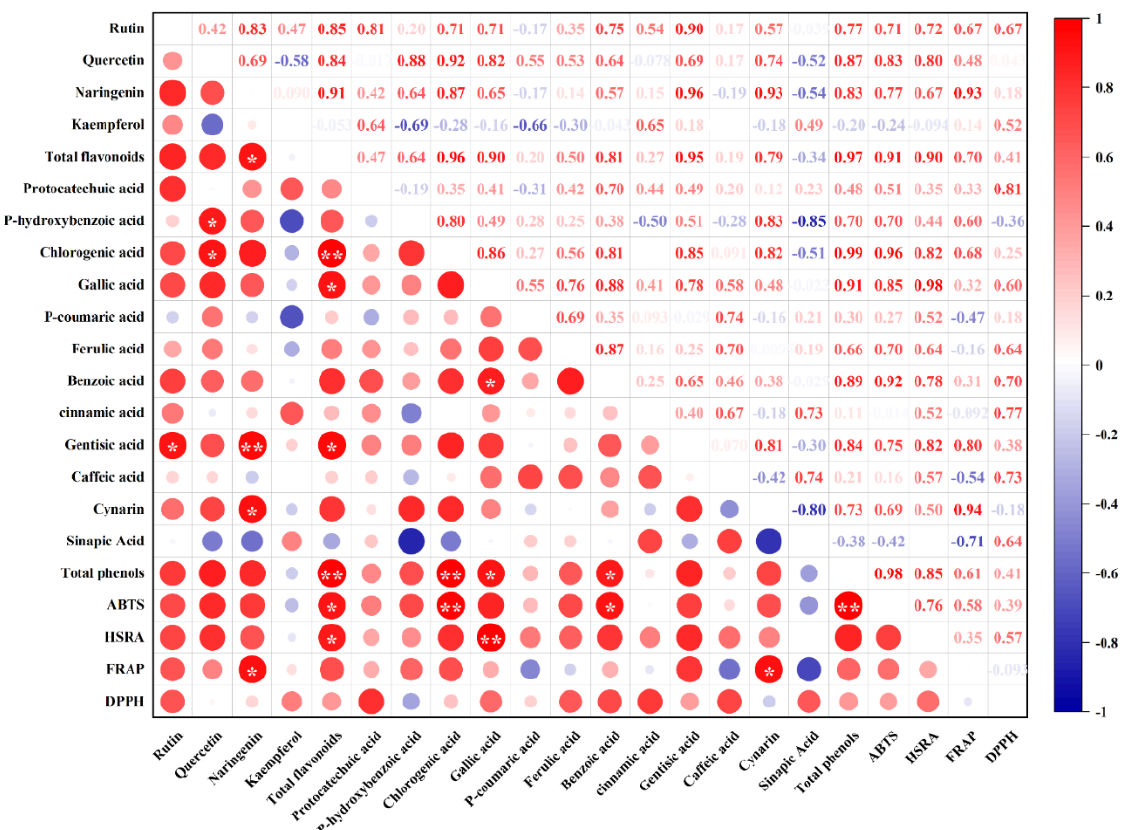
Figure 2. Pearson’s correlation analysis of polyphenols and antioxidant activity in tomato fruit under different levels of water deficit. ABTS, HSRA, FRAP, and DPPH are as defined in the legend of Figure 1. The abbreviations CK, T1, T2, T3, and T4 are defined in the footnote of Table 1. * and ** represent significant correlations at the p < 0.05 and p < 0.01 levels, respectively (two ‐ tailed).